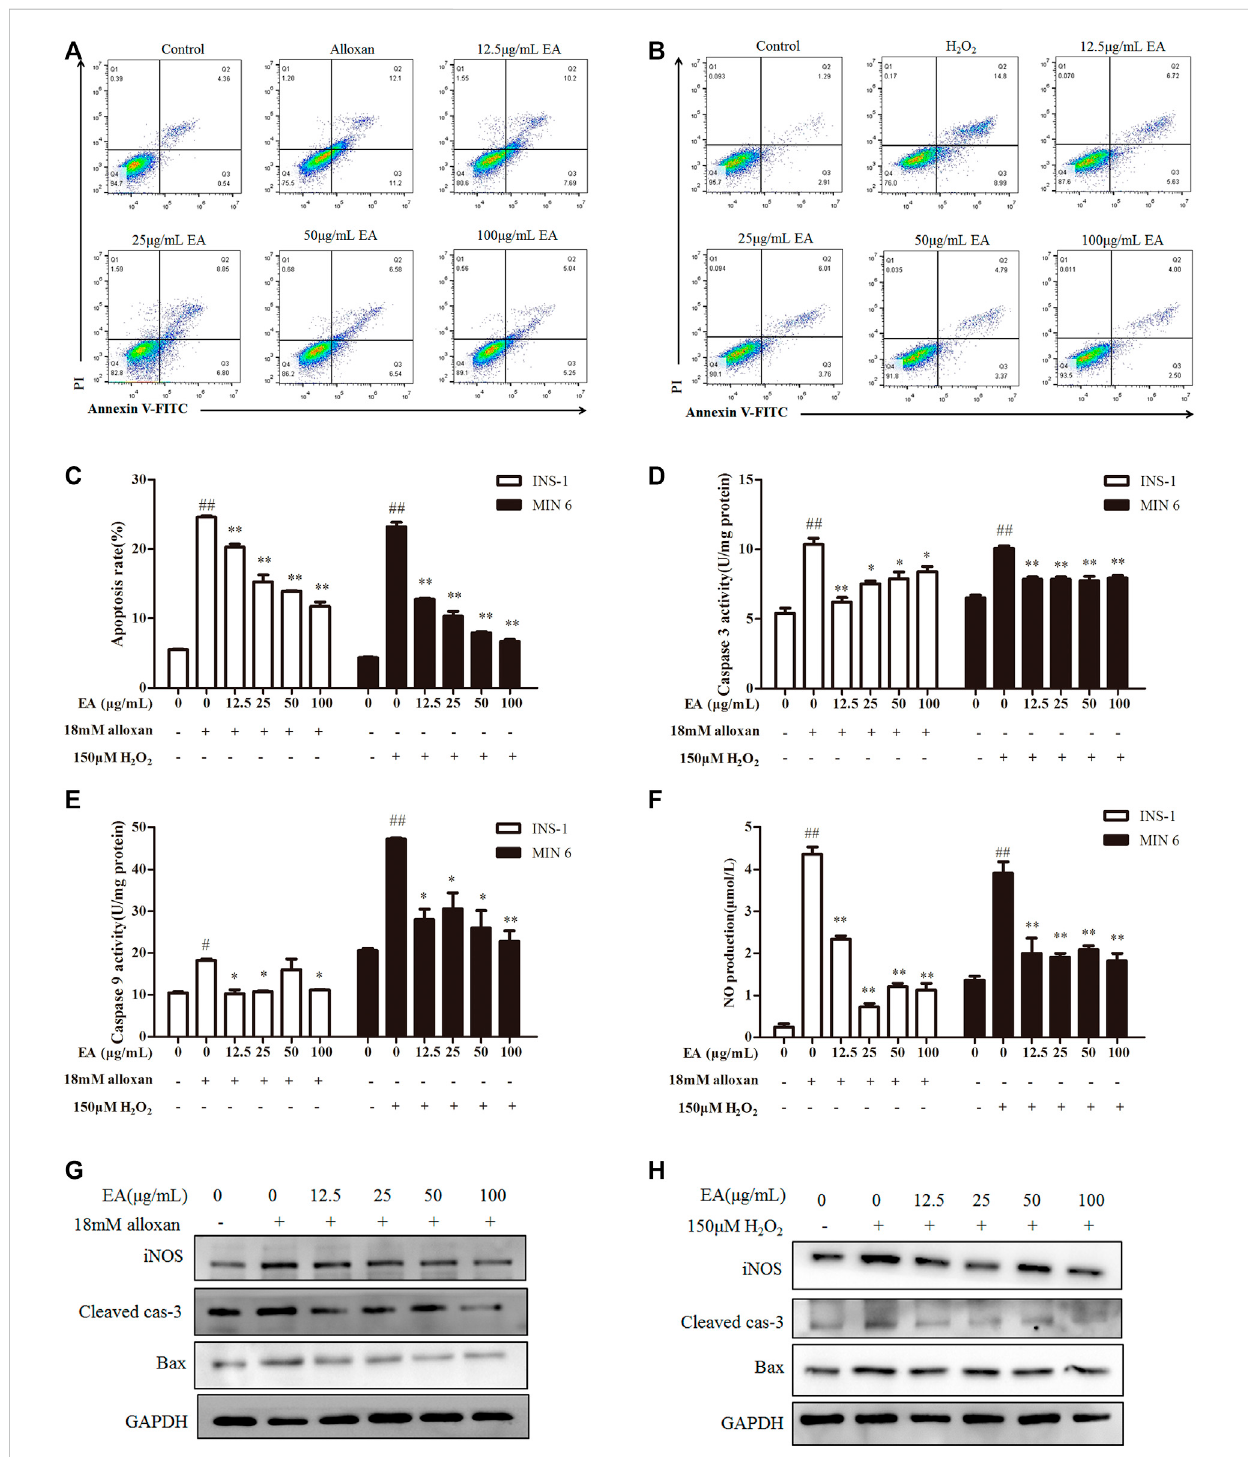
FIGURE 3 Effect of EA on apoptosis of β cells. INS-1 cells were incubated with EA (12.5 – 100 μ g/mL) and alloxan for 24 h. MIN6 cells were incubated with EA (12.5 – 100 μ g/mL) and H 2 O 2 for 24 h. Levels of apoptosis-related makers were determined. (A – C) Effect of EA on apoptosis was detected with fl ow cytometry, (D,E) EffectofEAontheactivityofcaspase-3and caspase-9. (F) Effect ofEAonNOrelease intothesupernatant. (G,H) Westernblots showing proteinexpressionofiNOS,Bax,andcleavedcaspase-3.Dataarethemean±SEM,n=3. # p < 0.05comparedwithcontrol, ## p < 0.01comparedwith control, * p < 0.05 compared with the OS-model group, ** p < 0.01 compared with the OS-model